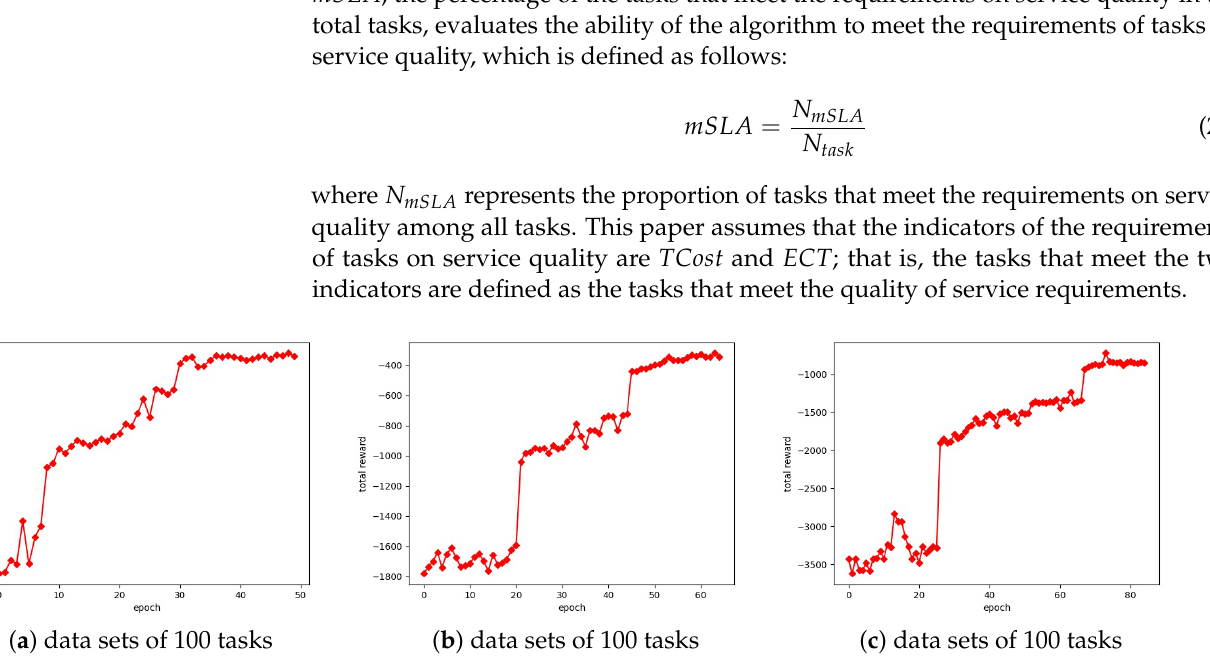
Figure 4. The total reward of the A2C on data sets of different numbers of tasks.